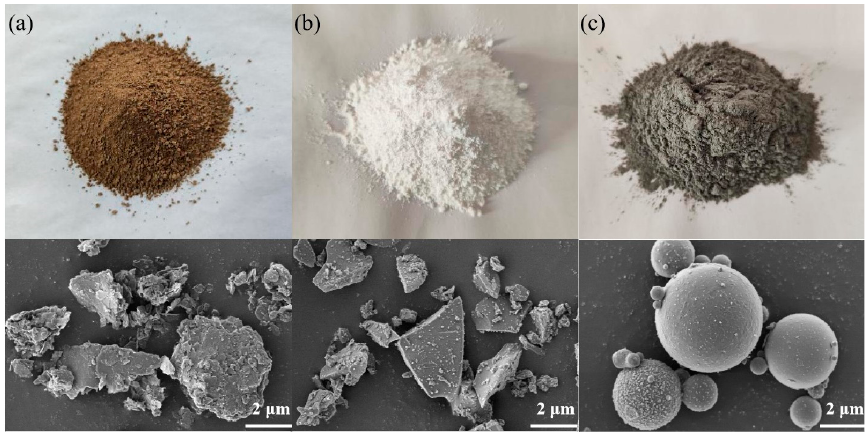
Figure 1. The appearance and microscopic images of raw materials: ( a ) soft soil; ( b ) slag; and ( c ) fly ash. Previous experimental studies [26,27] revealed that the use of composite alkali acti- vators produced the best activation effect on geopolymer precursor materials, especially the NaOH + Na 2 SiO 3 solution, as opposed to single alkali activators such as caustic soda, alkali silicate, and alkali carbonate. In addition, the modulus of the alkali activator has an important role in influencing various aspects of the geopolymer, such as its mechanical and workability properties. Wang et al. [28] stated that the optimal control range for the modulus of alkali activators was 1.0–1.5. Therefore, in order to make this study more capable of being referenced, a NaOH + Na 2 SiO 3 solution was used as the alkali activator and its modulus was set to 1.2. Both the NaOH and Na 2 SiO 3 solutions used in the test were commercially available materials, as is shown in Figure 2. The NaOH was in the form of white flakes of varying shapes and was analytically pure, while the Na 2 SiO 3 solution was clear and viscous with a modulus of 3.31, and contained mainly Na 2 O (8.42 wt%) and SiO 2 (27.84 wt%) in the form of oxides. The alkali activator modulus was adjusted by adding 19.14 g of NaOH fragments per 100 g of Na 2 SiO 3 solution.